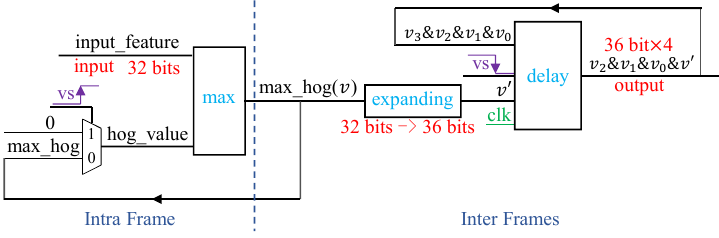
Figure 9. HOG feature storage for object